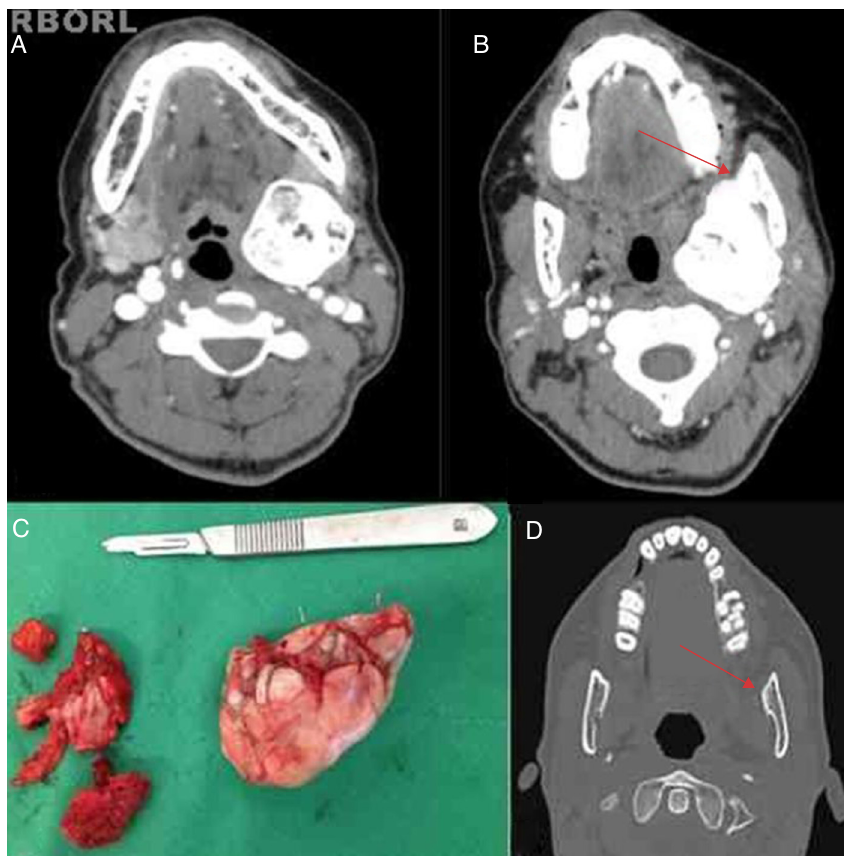
(A) Contrasted computed tomography of the face, showing an osteoma of the mandible. Axial view exhibiting large mass with a bony component occupying the parapharyngeal space. (B) Computed tomography, axial view exhibiting pedicle (red arrow) on the internal aspect of the left angle of the mandible. (C) Surgical specimen, osteoma removed through resection of its pedicle to the left angle of the mandible. (D) Follow-up computed tomography demonstrating no lesions (the red arrow shows the point at which the osteoma was